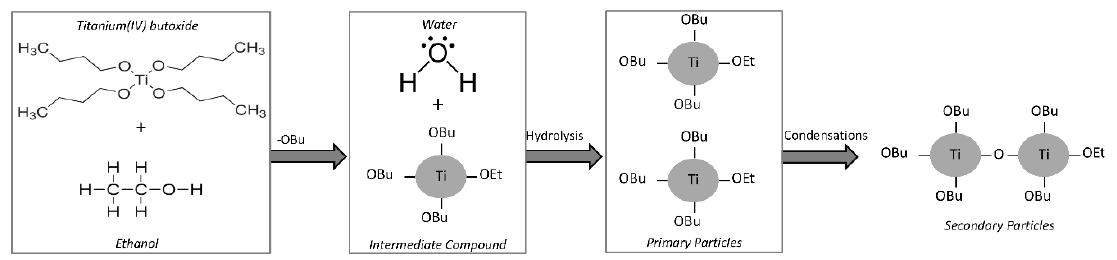
Figure 2. TiO 2 nanoparticle formation mechanism.